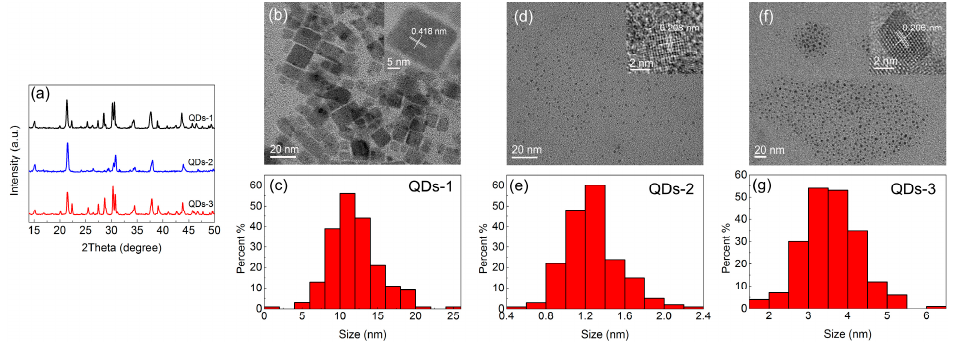
Figure 2. ( a ) XRD patterns of QDs-1, QDs-2, and QDs-3; ( b ) TEM image and ( c ) particle size statistical chart of QDs-1; ( d ) TEM image and ( e ) particle size statistical chart of QDs-2; ( f ) TEM image and ( g ) particle size statistical chart of QDs-3. Table 1. Parameters of three groups of QDs-M, weak polar solvent, dosage of PbBr 2 , precursor flow velocity, temperature, and wavelength.